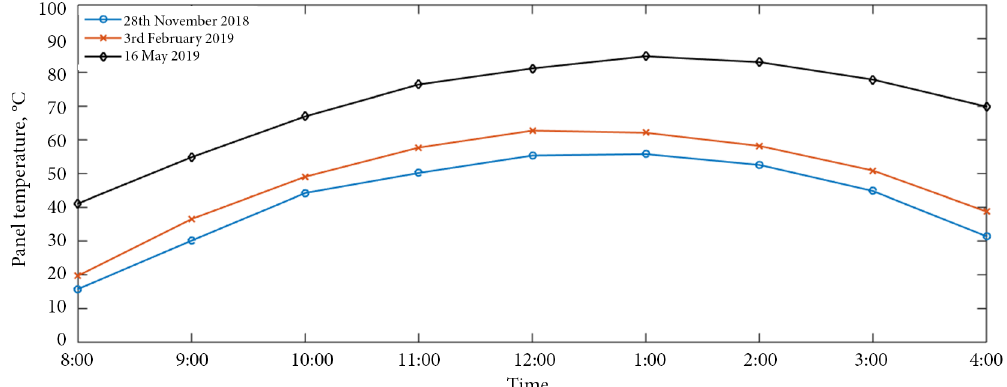
Figure 12. Variation of the panel temperature during selected three